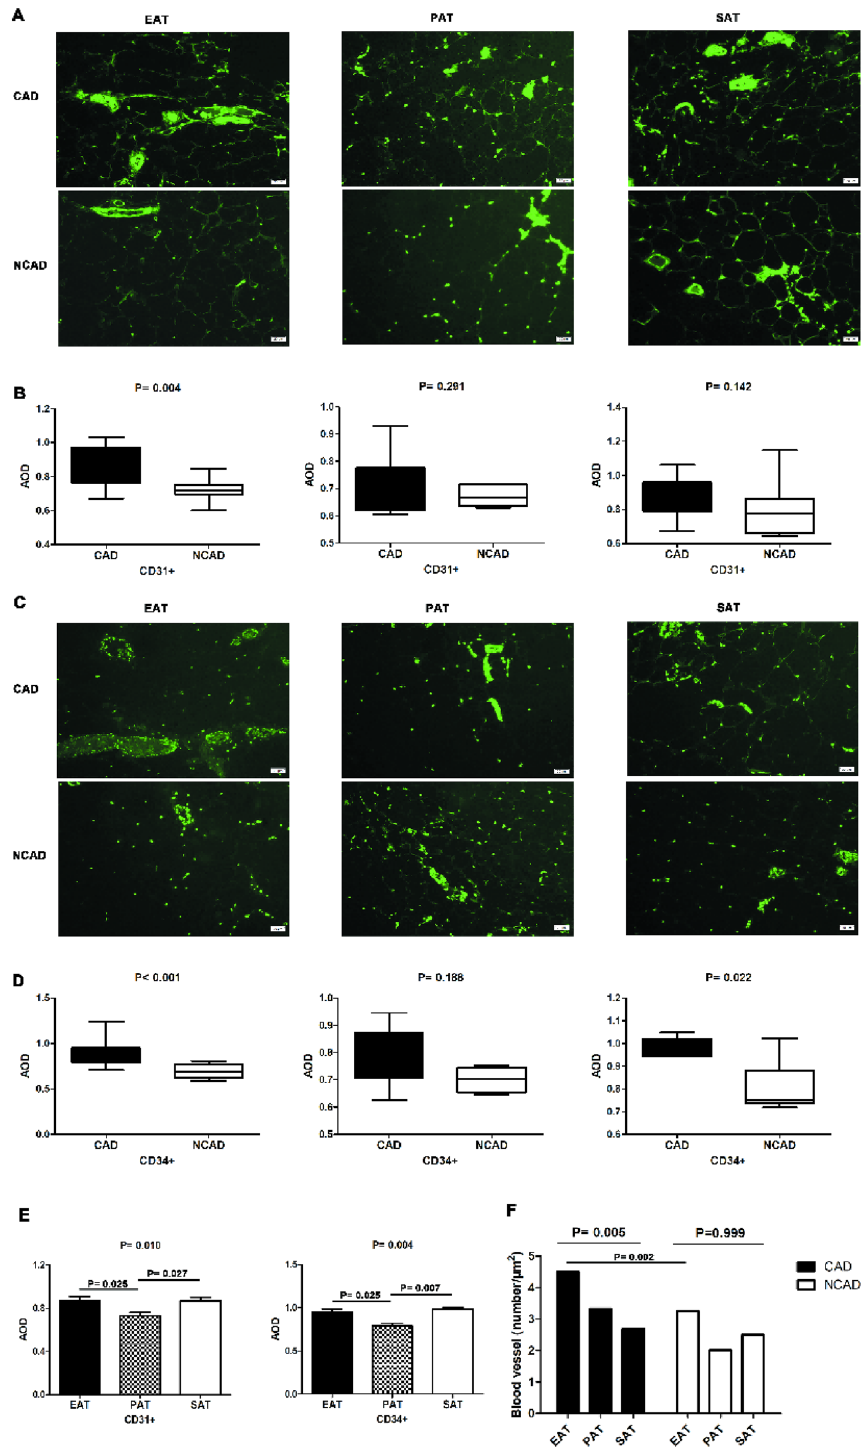
Figure 7. Immunofluorescence detection of CD31+ and CD34+ expression in adipose tissues in CAD (n = 19) and NCAD groups (n = 9). ( A ) Representative images of CD31+ expression in EAT, PAT and SAT. ( B ) AOD of CD31+ in EAT, PAT and SAT. C , Representative images of CD34+ expression in EAT, PAT and SAT. ( D) , AOD of CD34+ in EAT, PAT and SAT. ( E ) AOD analyses of PDPN, LYVE-1 between EAT, PAT and SAT in CAD patients. ( F ) The number of blood vessels in EAT, PAT and SAT. The Mann–Whitney U test was used to compare the relationship between the CAD and NCAD groups. The Kruskal–Wallis H test was used for the comparison among the three groups, and the multiple comparison between the groups was used “all pairwise”, the test level was adjusted to P =